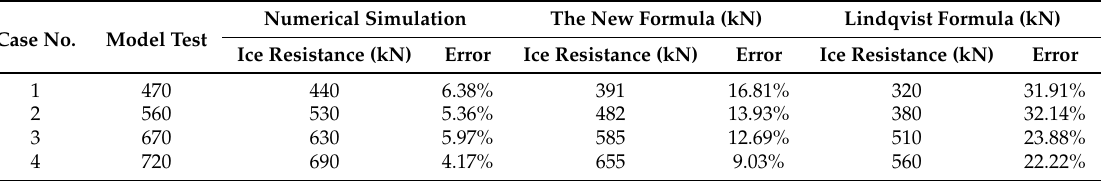
Table 3. The ice resistance values obtained by model test, numerical methods proposed in [7], the new formula and the Lindqvist